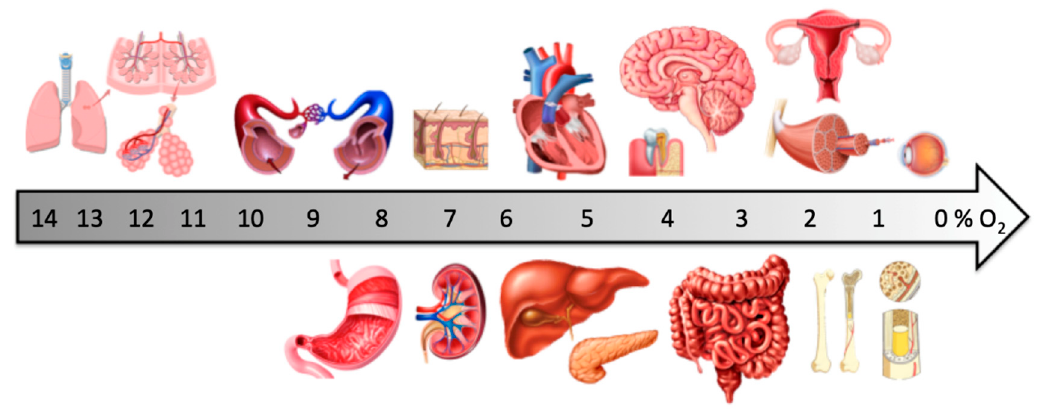
Figure 1. Oxygen partial pressure in tissues.